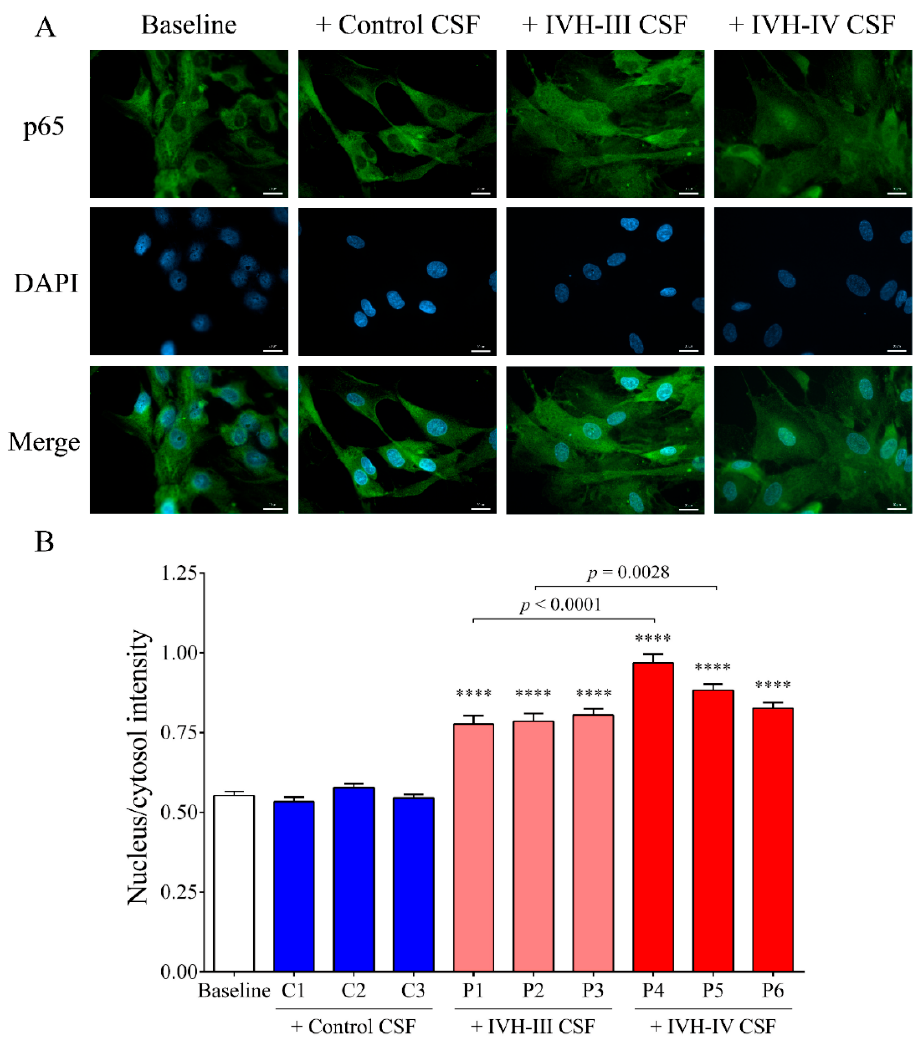
Figure 7. NF- κ B pathway activation via p65 nuclear translocation was visualized by immunoflu- orescence staining in HCPEpiCs ( A ) and the ratio of the fluorescence intensity of the NF- κ B im- munostaining in cell nuclei and cytosol was analyzed ( B ). Representative images of vehicle (baseline) or ex vivo CSF-treated cells are shown ( A ). Specific p65 staining: green; cell nuclei: blue (DAPI). Scale bar: 20 µm ( A ). When HCPEpiCs were exposed to IVH-III (light red, P1–P3) or IVH-IV (red, P4–P6) CSF for 1 h, the nucleus/cytosol intensity of the p65 staining was significantly increased compared to non-IVH controls (blue, C1–C3) ( B ). Mean ± SEM values are depicted, n = 15–25 cells were analyzed/group. **** p < 0.0001 vs. control samples based on the ANOVA test with Bonferroni’s multiple comparison test. Abbreviations: CSF, cerebrospinal fluid; HCPEpiCs, human choroid plexus epithelial cells; IVH, intraventricular hemorrhage; and NF- κ B, nuclear factor-kappa B. To provide further evidence on the involvement of the NF- κ B pathway in IVH- mediated cellular activation, a specific NF- κ B pathway inhibitor, BAY 11-7082, was used to prevent the activation of this signaling in HCPEpiCs under IVH-specific conditions. For this purpose, cell cultures were preincubated with BAY 11-7082 for 4 h and both non-IVH and IVH CSF specimens (10 v / v %) were added for 24 h (Figure 8). HMOX1, IL8, and ICAM1 mRNAs were quantified by RT-qPCR as described below. Treatment with BAY 11-7082 alone did not alter gene expression in a significant manner, while the NF- κ B path- way inhibitor resulted in a significant decrease in HMOX1 ( p = 0.0213), IL8 ( p = 0.0351), and ICAM1 ( p = 0.0054) mRNA levels that were induced by IVH CSF (Figure 8A–C). These results suggest that the pro-inflammatory components accumulated in the CSF after the